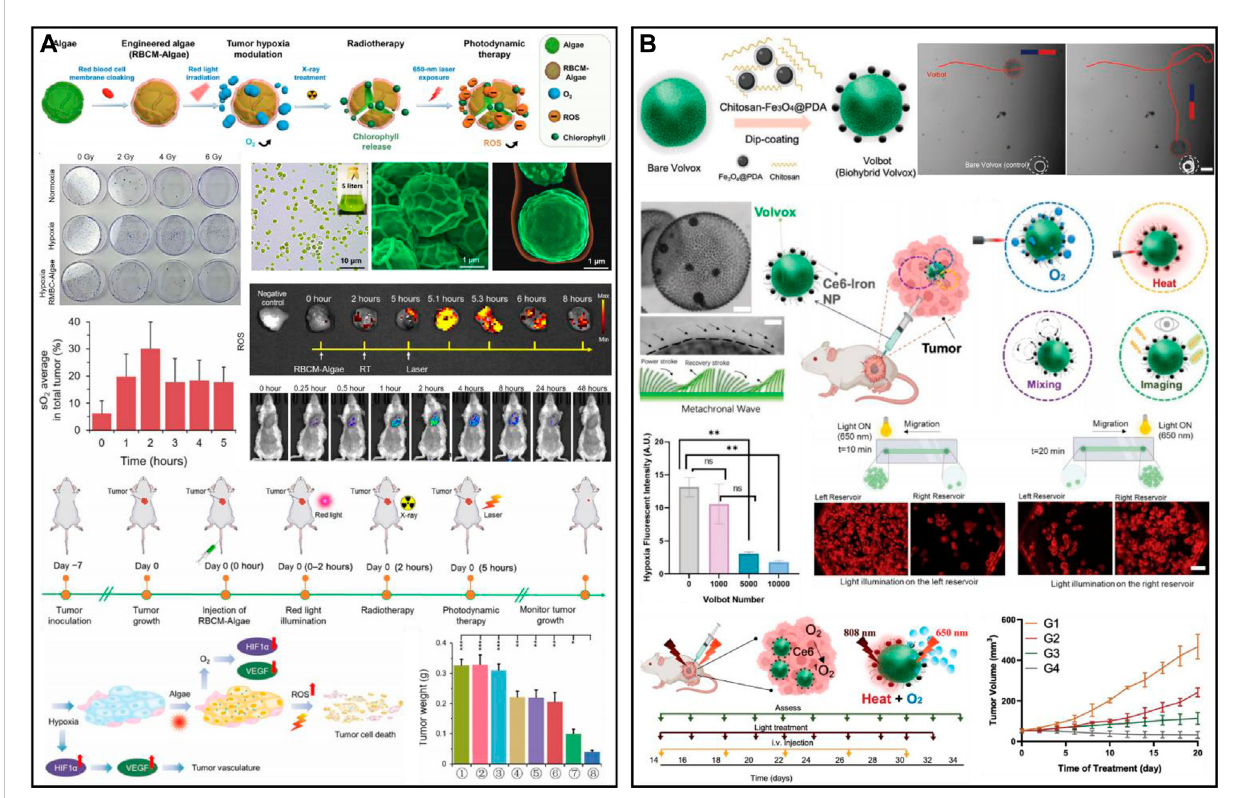
FIGURE 9 (A) RBCM-Algae for hypoxic cancer. Reproducedfrom ref. (Wang et al., 2022b) with permission from American Association for the Advancement of Science,copyright2020. (B) MultifunctionalmicroroboticVolbotfortumorimagingandtherapy.Reproducedfromref.(Qiaoetal.,2020)withpermission from Wiley, copyright